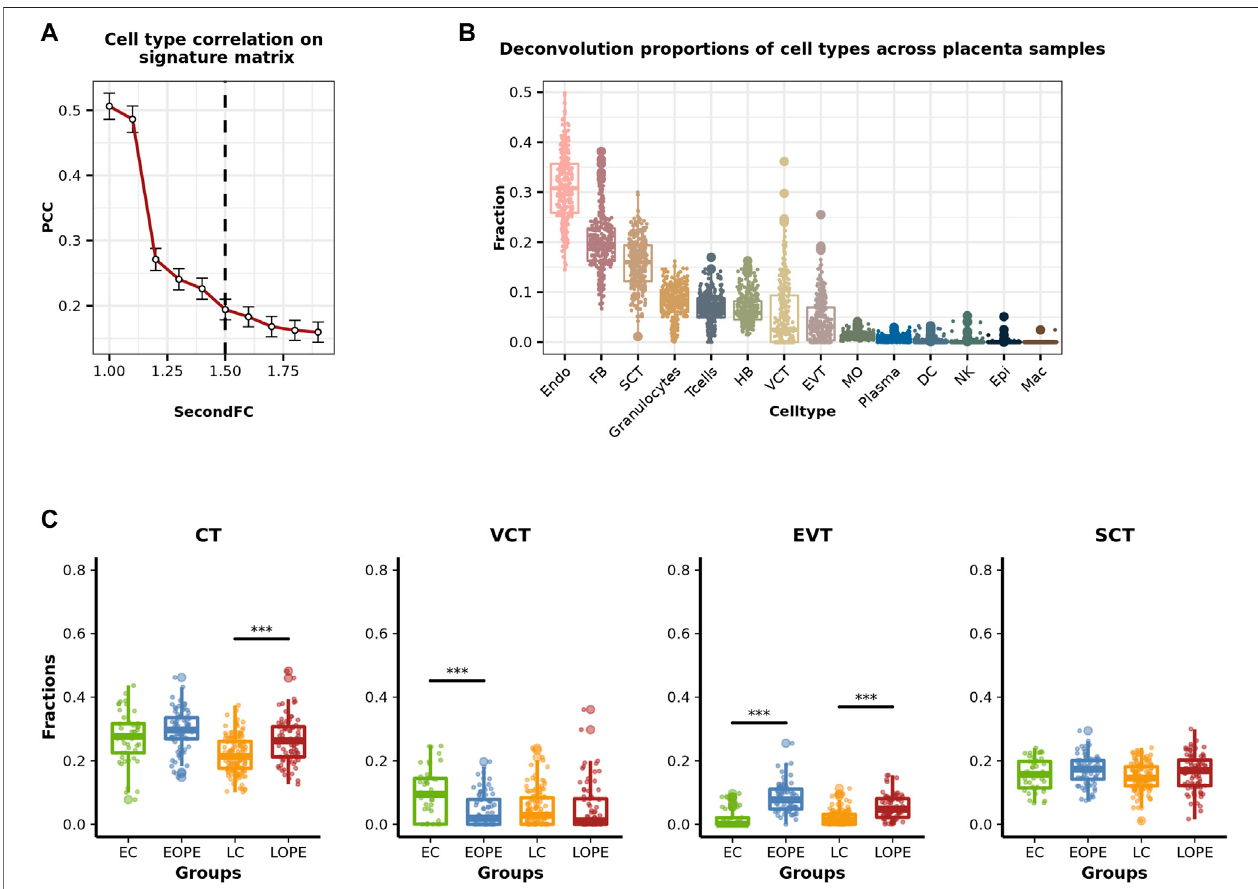
FIGURE2| Estimatedcell-typeproportionsofplacentalsamplesincludedinthecohortofplacentalmicroarraydata. (A) AveragePCConplacentasignaturematrix changing with SecondFC cutoff. (B) Boxplots of the estimated proportions of different placental cell types in the cohort of placenta microarray data. (C) Comparison of the estimated proportions of trophoblasts between PE and normal samples. CT: cytotrophoblast, EC: early-stage control, EOPE: early-onset preeclampsia, LC: late- stage control, LOPE: late-onset preeclampsia.